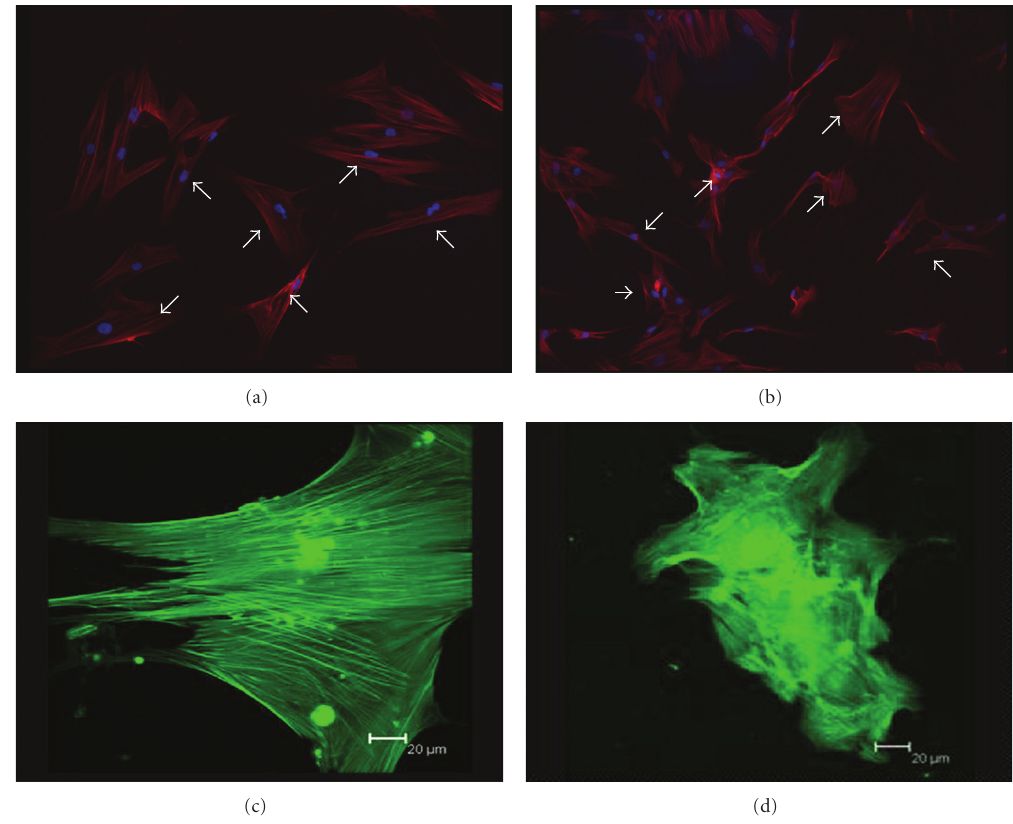
Figure 3: Actin distribution patterns in BMMSCs from SLE patients or the normal controls. (a, b) Actin filaments were stained with Alexa Flour 594 conjucted phalloidin (red) and nuclei were counterstained with DAPI (blue). Cells (white arrows) were observed by fluorescence microscope. (a): BMMSCs from normal controls, (b): BMMSCs from SLE patients. (magnification × 200) (c, d) Actin filaments was stained with phalloidin-FITC and observed under confocal microscopy. (c): BMMSC from one normal control, (d): BMMSC from one SLE patient (Bar =